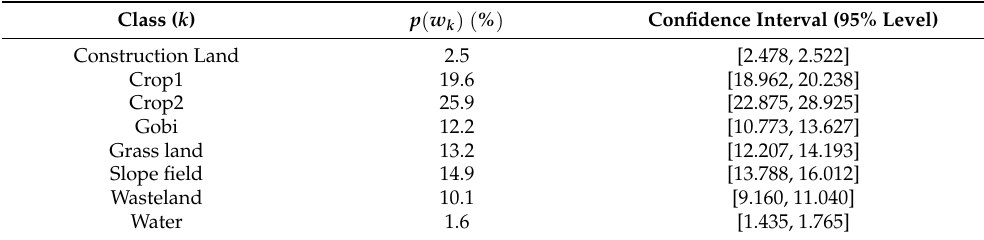
Table 1. Area proportion of each class estimated by sample